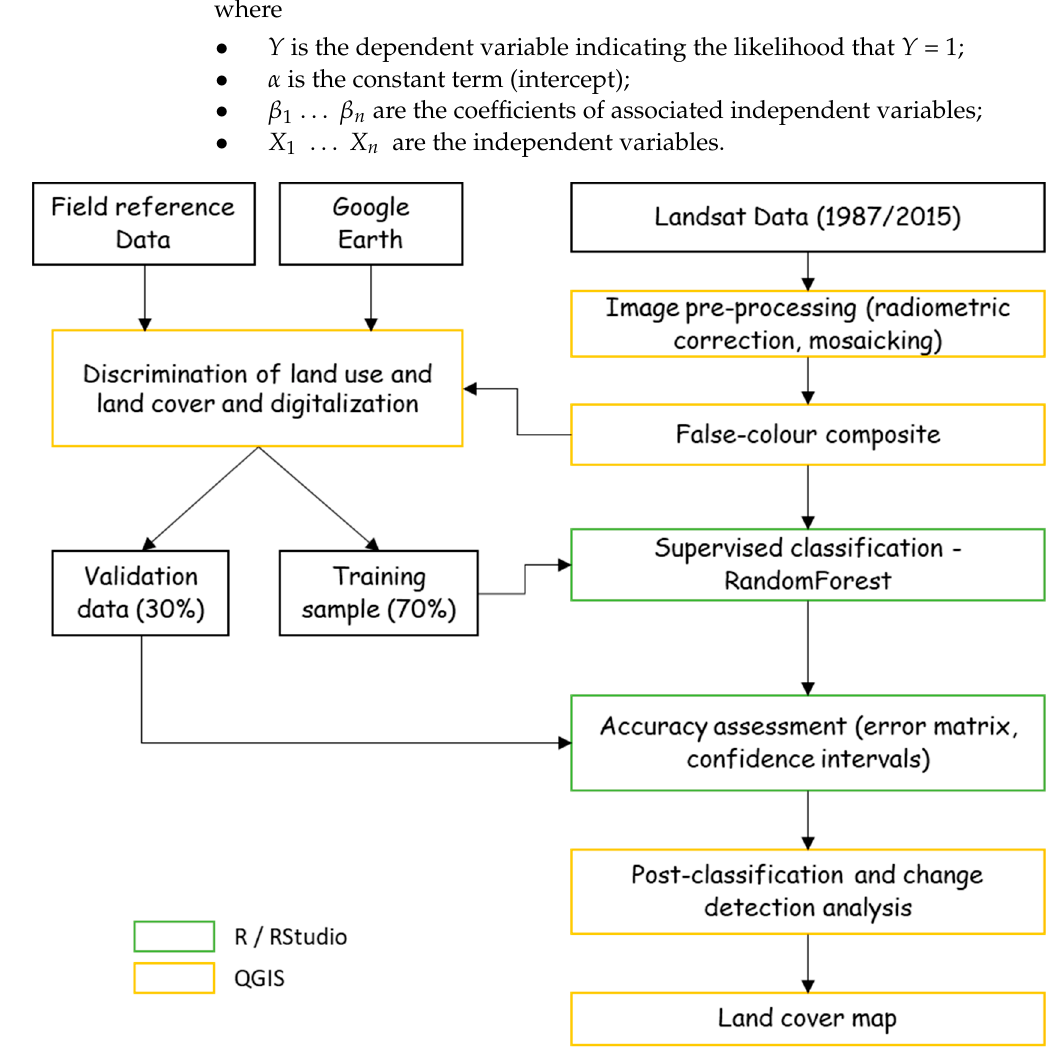
Figure 2. The LULC mapping process.